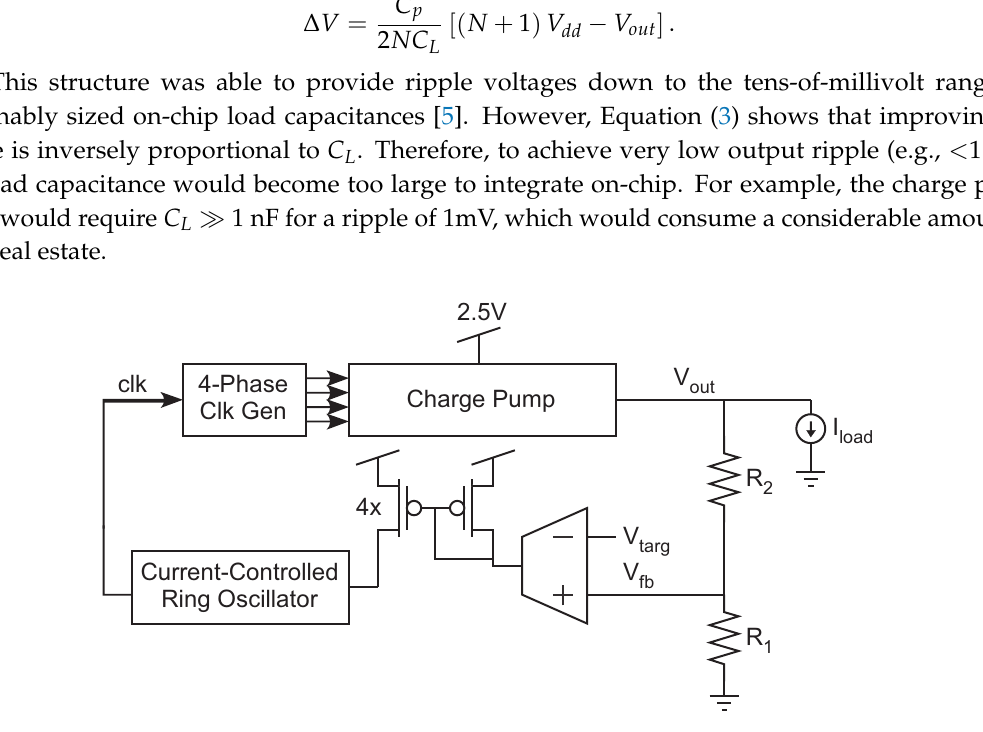
Figure 2. Due to the frequency regulation in the closed-loop structure, the output ripple value can be